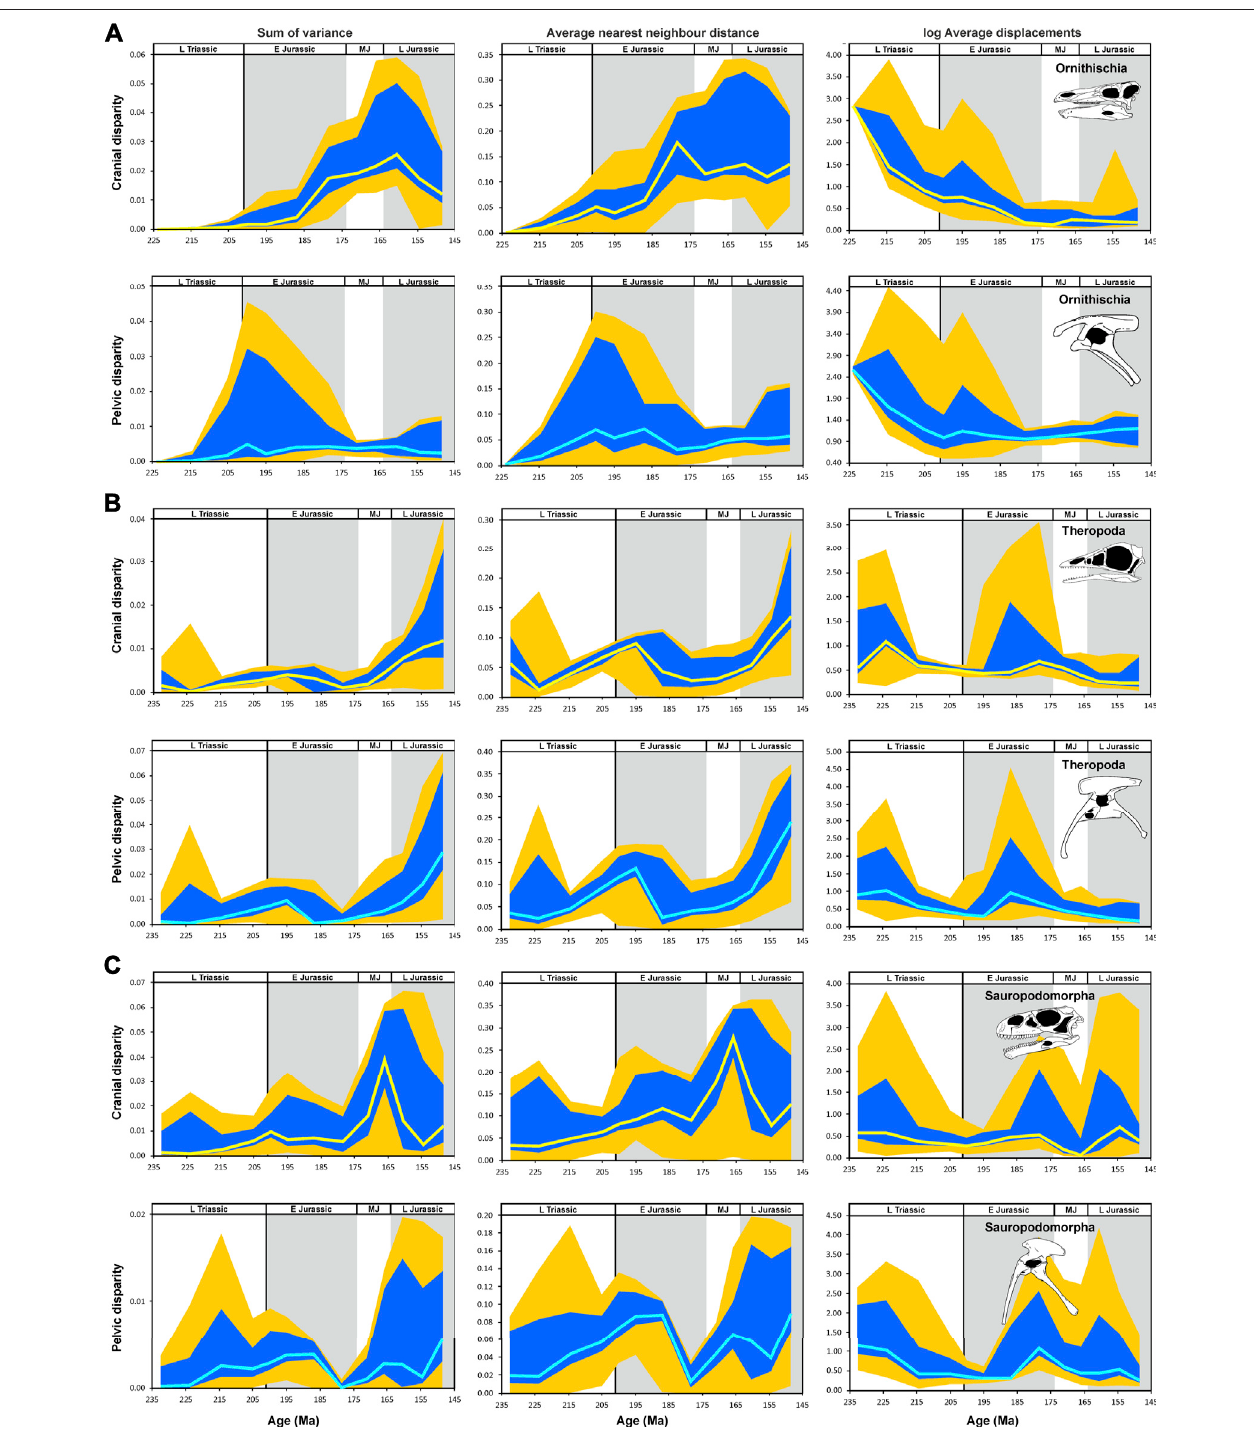
FIGURE 8 | Temporal disparity of archosauromorph cranium and pelvis captured by 2D geometric morphometrics from the late Permian to the Late Jurassic, as measured from phylogenetically interpolated values ( “ gradualistic ” model), with disparity quanti fi ed as the sum of variances, average nearest neighbor distance and averagedisplacements(log-transformed)basedonshapevariablesoftheprincipalcomponentanalysis. (A) Cranialandpelvicdisparityofornithischians. (B) Cranialand pelvic disparity of theropods. (C) Cranial and pelvic disparity of sauropodomorphs. The yellow (cranium) and cyan (pelvis) solid lines show the median of estimated disparity for each bin, with the orange bands showing the total range of disparity estimated from 1,000 time-calibrated trees and the blue band showing the range delimited by the 2.5 and 97.5% quantiles of the same. Stegosaurus skull (A) modi fi ed after Sereno and Dong (1992); Scelidosaurus pelvis (A) modi fi ed after Carpenter (2013); Archaeopteryx skull (B) modi fi edafterRauhut(2014); Coelophysis pelvis (B) modi fi edafterTykoski(2005); Adeopapposaurus (C) modi fi edafterMartínez(2009); Eoraptor pelvis (C) modi fi ed after Sereno et al. (2013). Abbreviations: P, Permian; ET, Early Triassic; MT Middle Triassic L Triassic, Late Triassic; E Jurassic, Early Jurassic; MJ, Middle Jurassic; L Jurassic, Late Jurassic ( Supplementary Material S1-Tables S4 – S6 ). Frontiers in Earth Science |